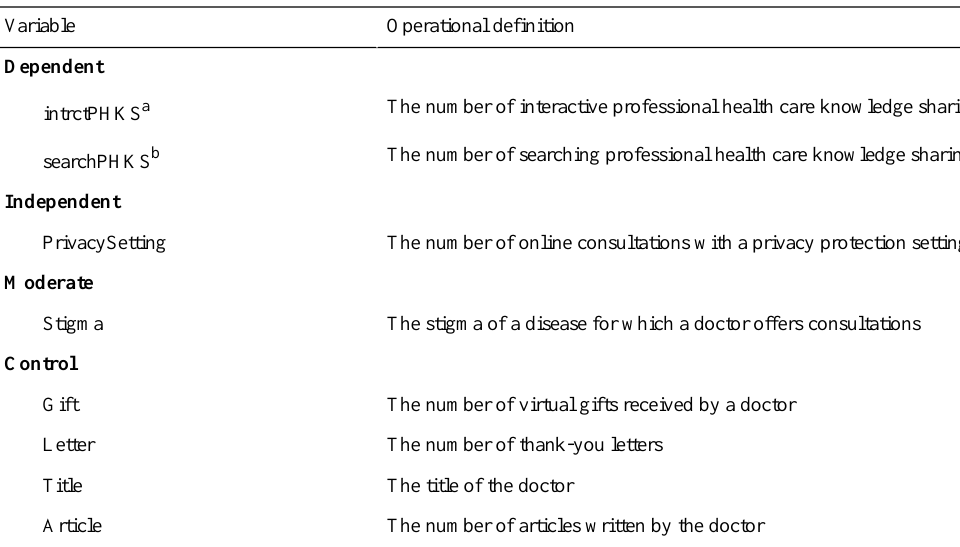
Table 1. Variables defined.